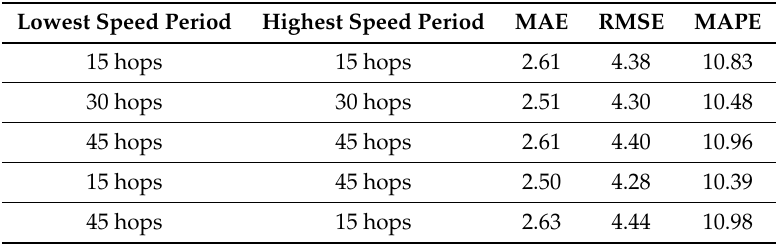
Table 5. The effect of reachability path length limit on speed